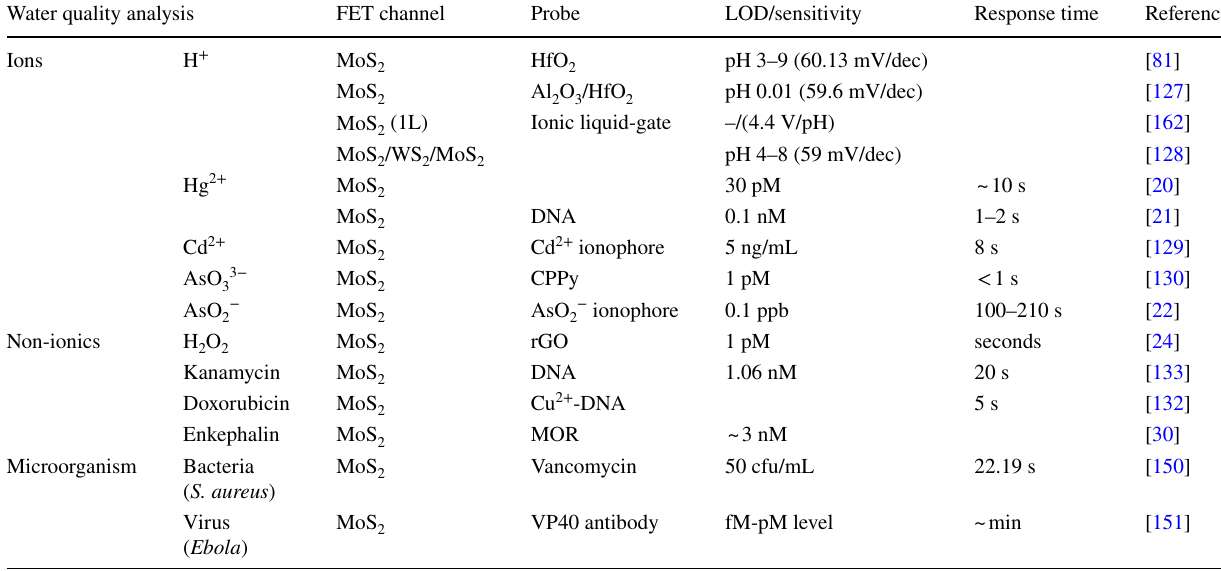
Table 2 Water quality analysis with 2D TMDC-based FET sensors: device structure and sensing performance